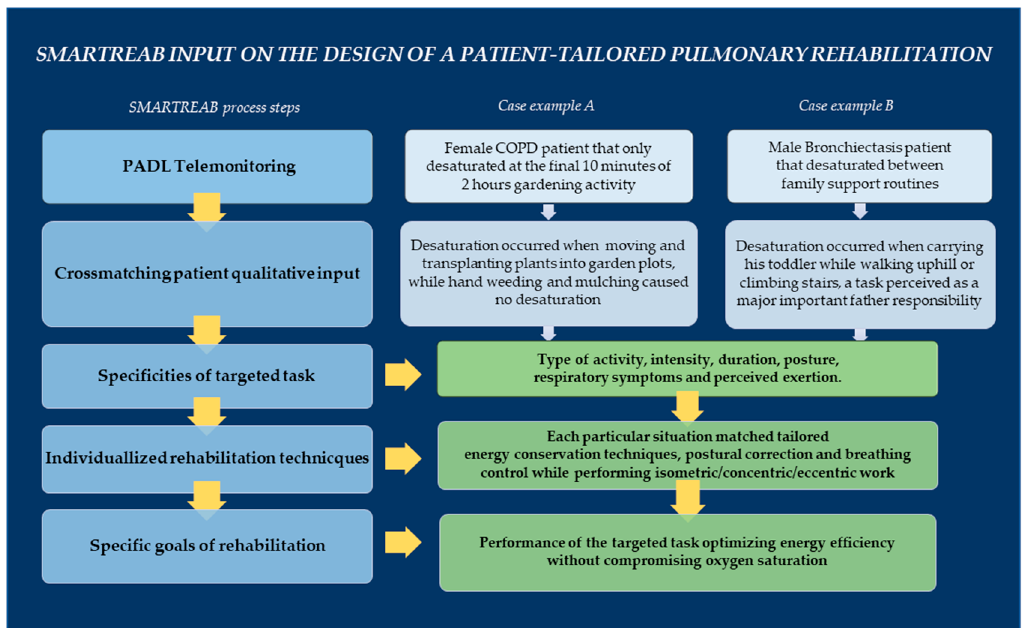
Figure 5. SMARTREAB rationale to operationalize single-patient PADL telemonitoring data as an input to set individually-tailored pulmonary rehabilitation goals. All patients, including cases A and B described, were the center of identification and characterization of targeted desaturation tasks, and thereby actively involved on specific goal-setting and commitment to intervention success.